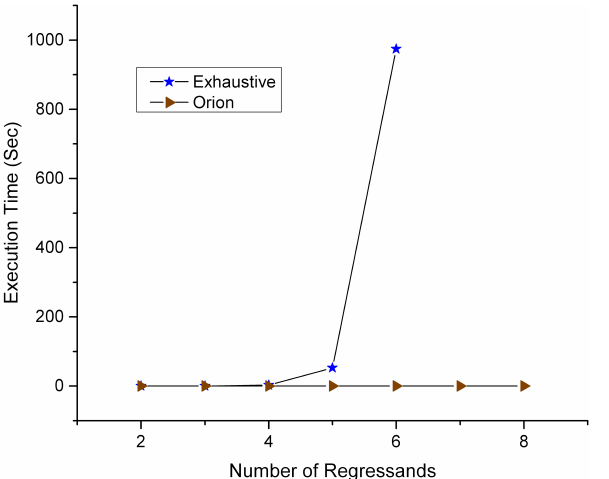
Figure 8. Execution time of Orion in contrast to the exhaustive